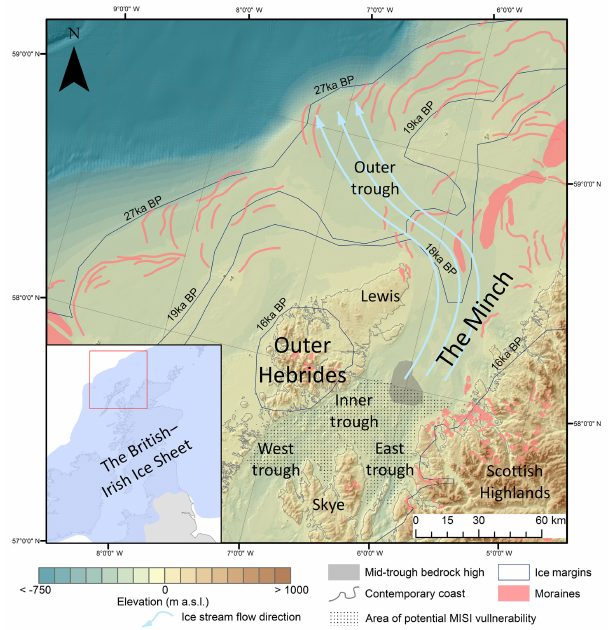
Figure 1. Location and geographical setting of the Minch Ice Stream. The inset shows the maximum extent of the British–Irish Ice Sheet from Clark et al. (2012). The red box indicates the Minch ice stream region shown in the larger map. Ice margins and dates are from Clark et al. (2012). Moraines are from the BRITICE glacial landform map, version 2 (Clark et al., 2018). The area of potential MISI vulnerability is inferred from the presence of marine retro- grade slopes. Key locations mentioned in the text are